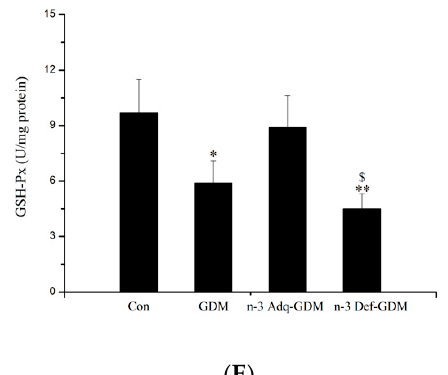
Figure 3. Oxidative stress in the liver of gestational diabetes mellitus (GDM) offspring at 11 months of age and the effect of n-3 polyunsaturated fatty acids (n-3 PUFA) on oxidative stress. ( A )The activity of SOD, ( B ) MDA, ( C ) The activity of CAT, ( D ) GSH, ( E ) The activity of GSH-Px. Bars are mean ± SD. n = 8 rats/group. * p < 0.05, ** p < 0.01, vs. Control offspring (Con); # p < 0.05, ## p < 0.01, vs. GDM offspring (GDM); $ p < 0.05, $$ p < 0.01, vs. n-3 Adequate-GDM offspring (n-3 Adq-GDM).